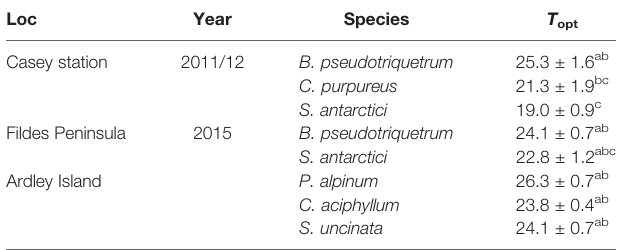
Data from Casey station: Dec/Jan 2011/12 (n = 5). Data from Fildes Peninsula and Ardley Island(KingGeorgeIsland):January2015(n=6).Dataaremeans±se.Letters:signi fi cant differences between species by Duncan post-hoc (P <